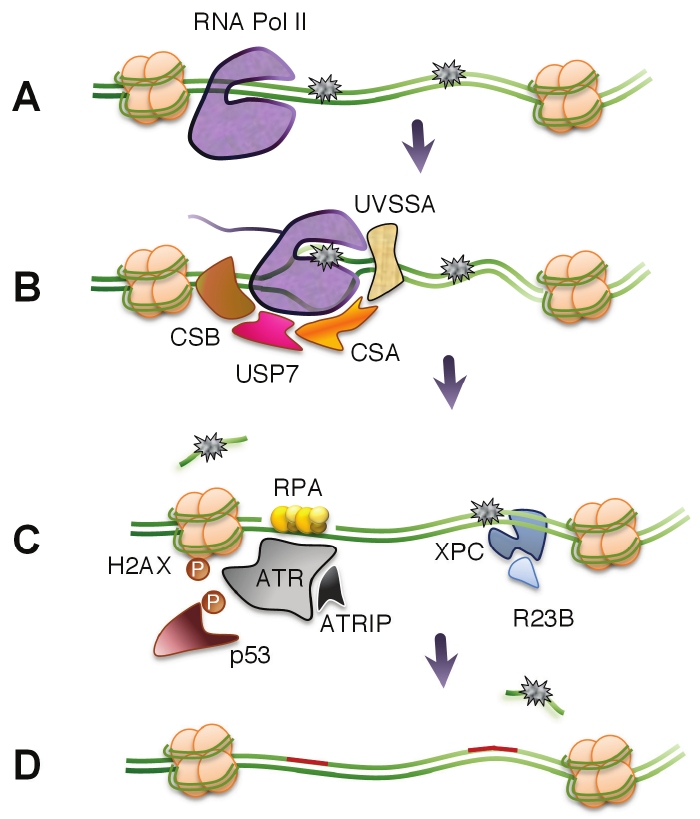
Figure 2. Removal of transcription-blocking DNA lesiosns. ( A ) Large genes are especially susceptible to gene inactivation by DNA-damaging agents. ( B ) Stalled RNA polymerase II promotes TC-NER by recruitment of CSB, CSA, UVSSA, and USP7 allowing for the remodeling of chromatin around the stalled RNA polymerase and the recruitment of core NER components. ( C ) Following removal of DNA damage, the gap formed may be extended by exonucleases and activate ATR kinase through RPA-binding to single-stranded DNA. Alternatively, blockage of transcription elongation may generate a single-stranded structure that binds RPA and activates ATR. The induction of the transcription stress response results in phosphorylation of ATR targets, including H2AX and p53. DNA lesions not associated with blocked RNA polymerases are substrates of GG-NER. ( D ) DNA repair is completed and the transcription stress response is